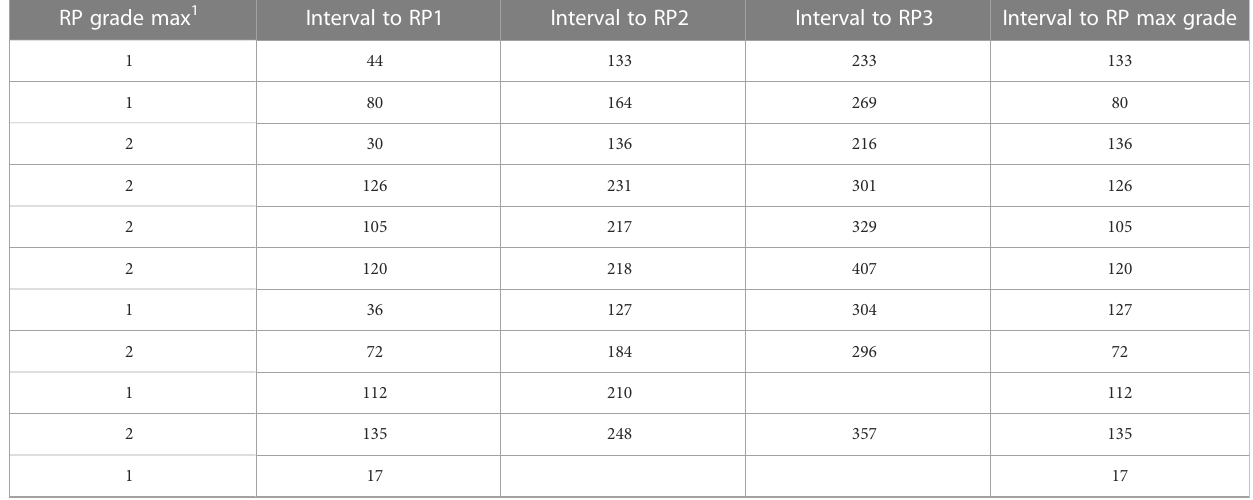
TABLE 2 RP grade max and interval of days to